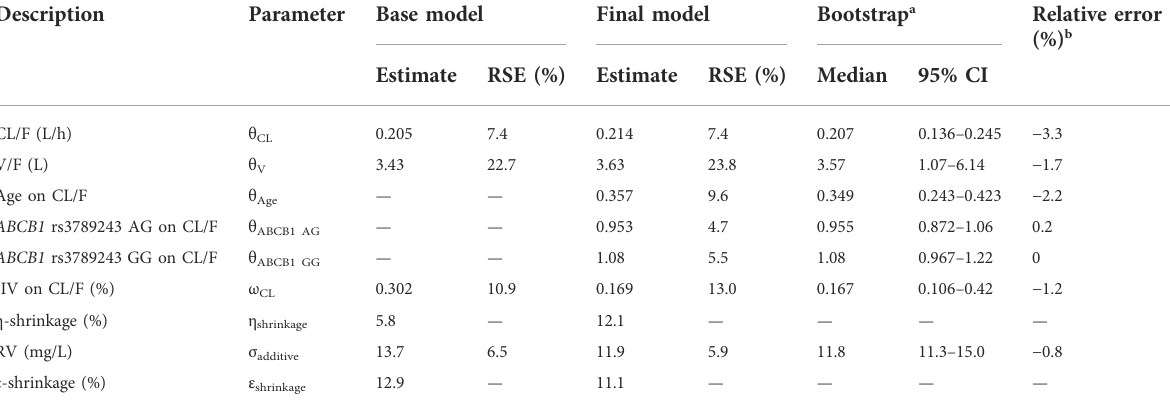
TABLE 4 PPK parameter estimates from the fi nal model and bootstrap validation.